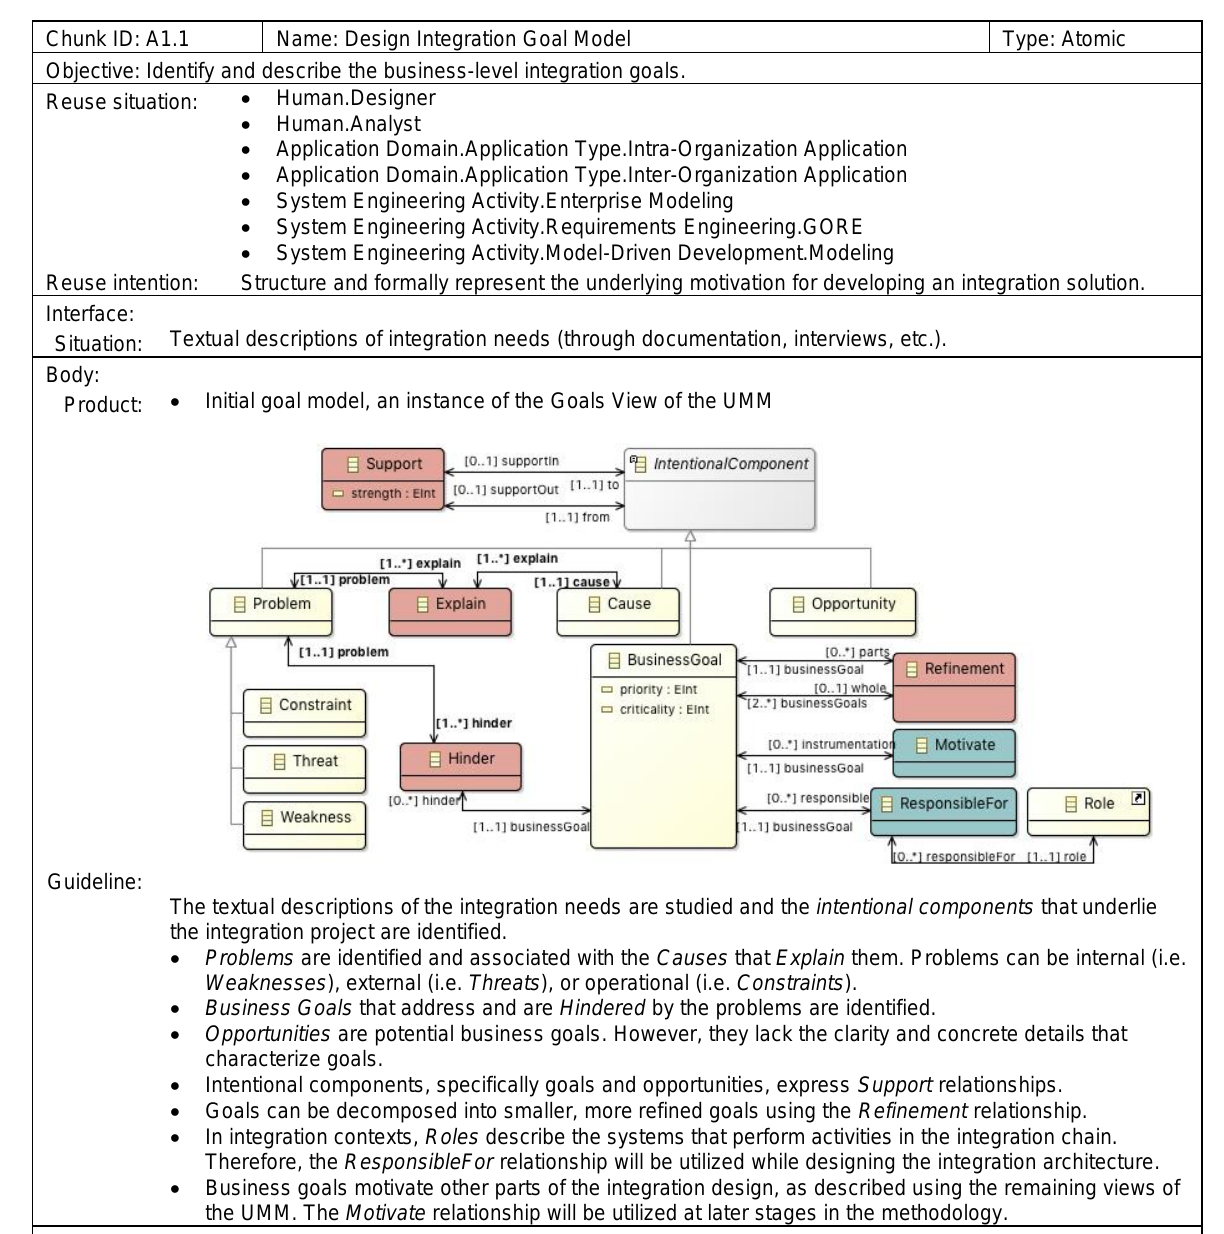
Table 1. Definition of method chunk A1.1